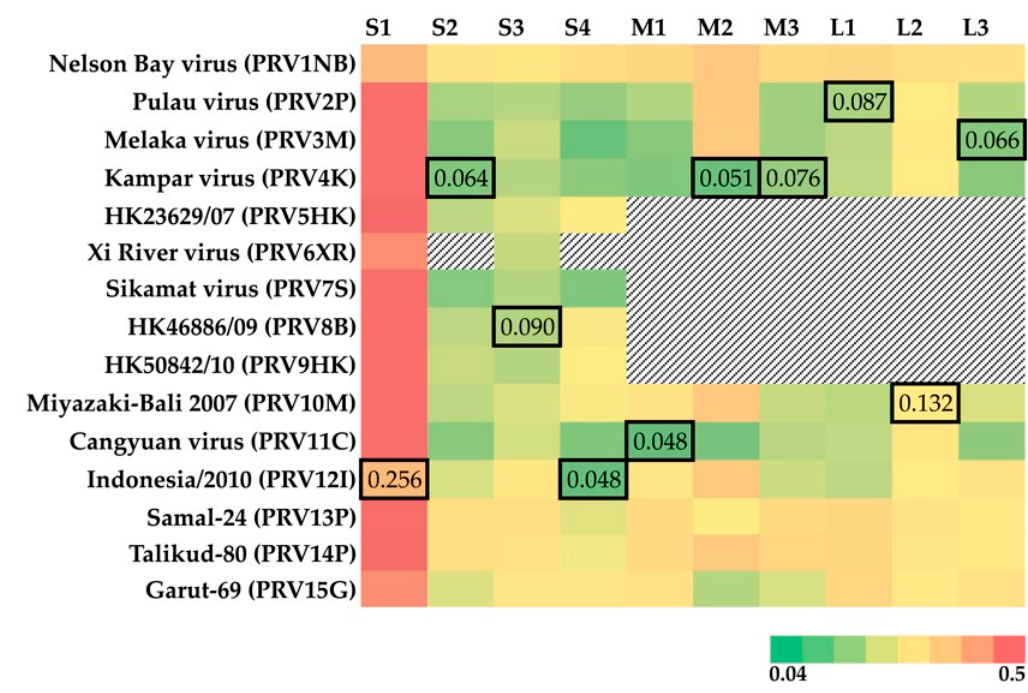
Figure 1. Heatmap of p-distance for the segments of 15 previously isolated PRVs relative to PRV16K. The pairwise p-distance was estimated using MEGA7 (1000 bootstrap replicates). The GenBank accession numbers for PRV isolates are available in Supplemental Table S1. The missing segments of PRV isolates are indicated by black and white hashed cells. The outlined cells indicate the lowest p-distance to PRV16K for each segment. The heatmap color key shows the range of the p-distance values estimated.